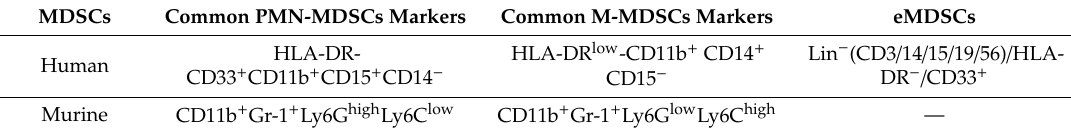
Figure 1. Di ff erentiation of MDSCs. The generation of immature myeloid cells (myelopoiesis) begins in the bone marrow. The hematopoietic stem cells (HSC) di ff erentiate into common myeloid progenitor (CMP) cells and then to immature myeloid cells (IMC). IMCs migrate to blood and various peripheral organs and under normal physiological conditions, di ff erentiate into granulocyte- macrophage progenitors (GMP) cells to further di ff erentiate into other progenitor cells and lineage-specific cell populations. Under pathological conditions including cancer, MDSCs are generated and acquire immunosuppressive functions. These MDSCs inhibit the antitumor immunity of e ff ector T cells (Te ff ) directly or via mechanisms including the crosstalk with other immunosuppressive cell types such as regulatory T cells (Tregs), tumor-associated macrophages (TAMs) and dendritic cells (DCs). Table 1. Summary of commonly expressed markers in human and murine